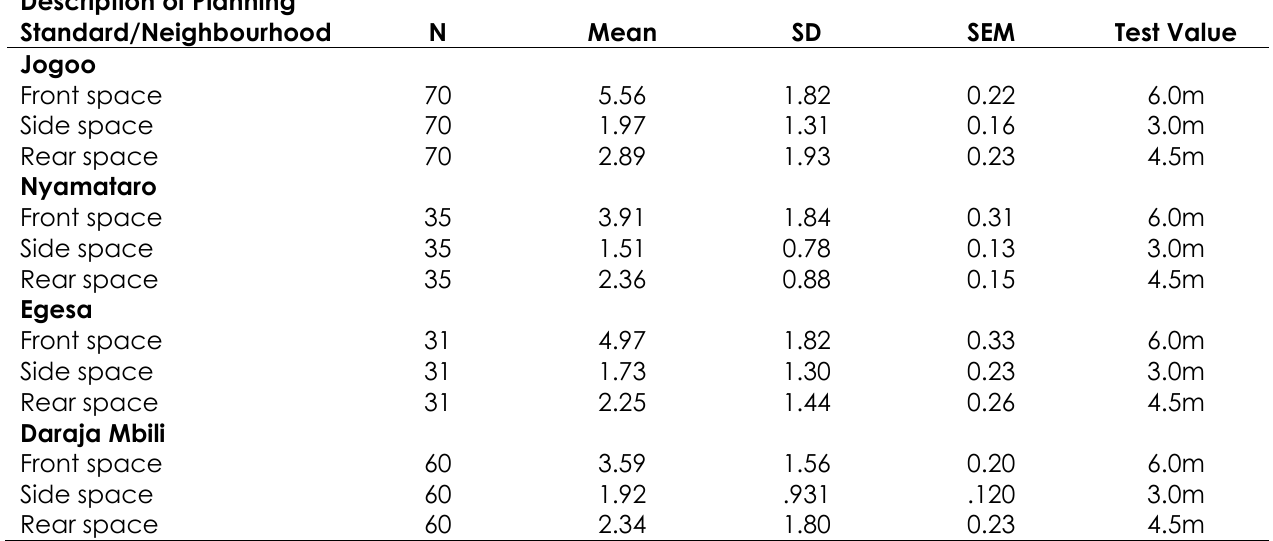
Table 2: One-sample statistics on compliance in Egesa, Nyamataro and Daraja Mbili Description of Planning